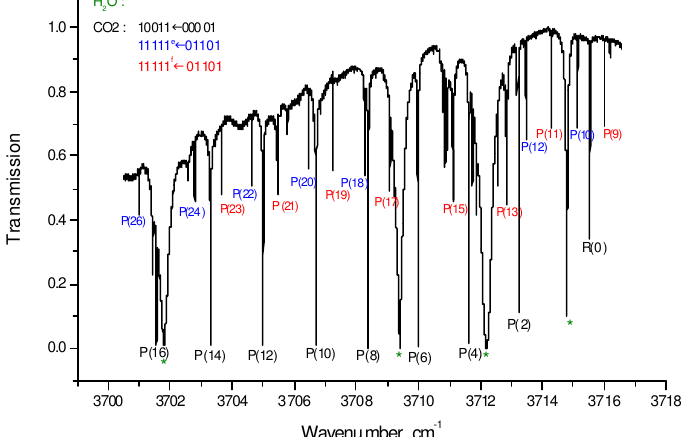
Figure 2. CO absorption lines (here for a 10 cm long cell filled with CO 2 mbar) present in the spectral emission window of the 2.7 µm